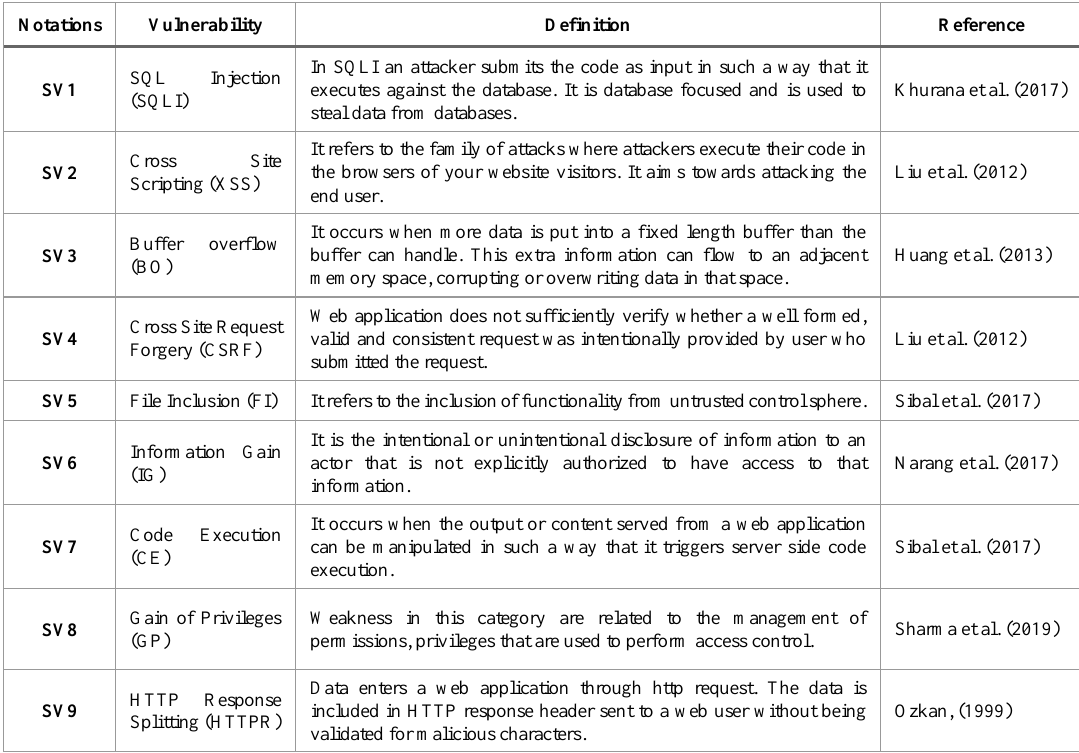
Table 1. Description of software vulnerabilities with